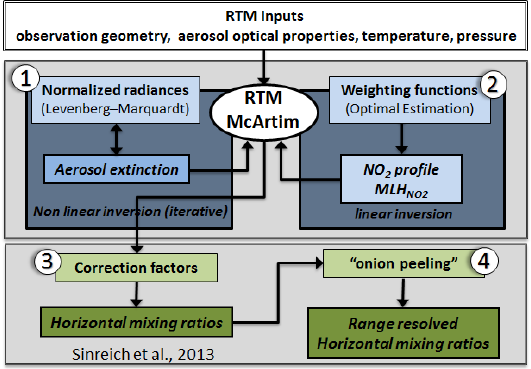
Figure 4. A four-step retrieval is applied: (1) aerosol extinction is determined at O 4 wavelengths by means of nonlinear inversion using normalized radiances; (2) the trace gas vertical profiles are derived (see text). The center shaded area represents the inversion of the EA scan measurements using OE, from which the MLH is determined. The lower shaded area represents parameterization of RTM that uses MLH as input to determine (3) near-surface VMR (Sinreich et al., 2013), and (4) range-resolved NO 2 VMRs using an “onion-peeling” approach and NO 2 measurements at different